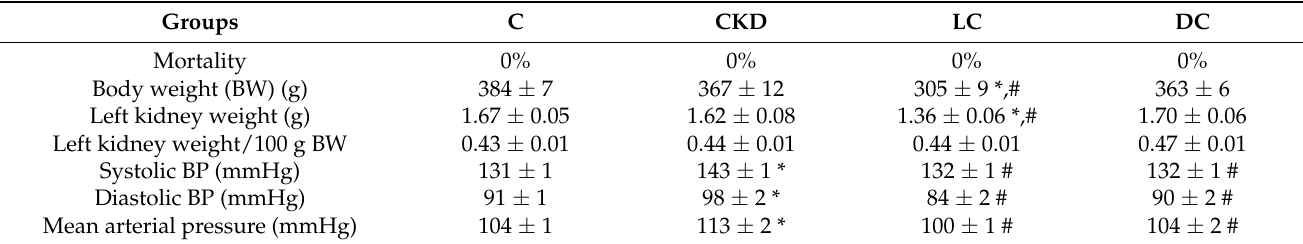
Table 2. Weight and blood pressure of male